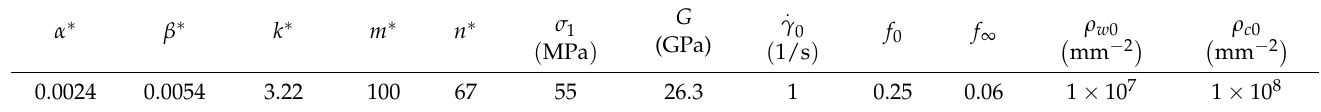
Table 1. Material parameters of the dislocation density-based constitutive model for pure Al